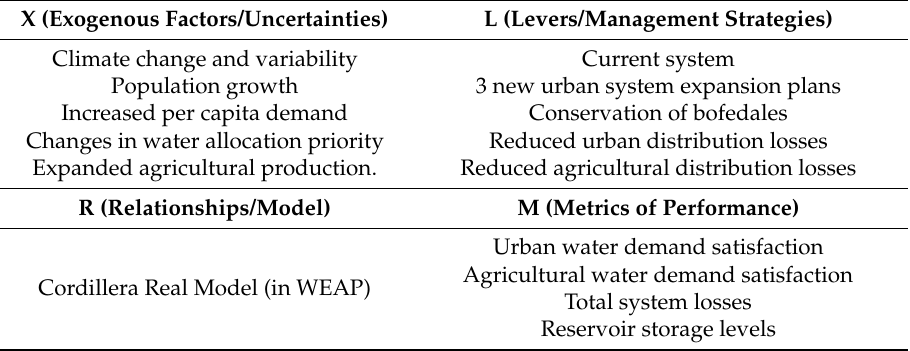
Table 1. Initial XLRM problem formulation matrix developed by a focal group of stakeholders representing various constituencies convened by the Bolivian Ministry of the Environment and Water during a one-day problem formulation workshop held in La Paz,